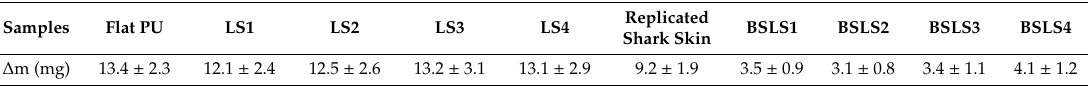
Table 1. Measured residual mass of the